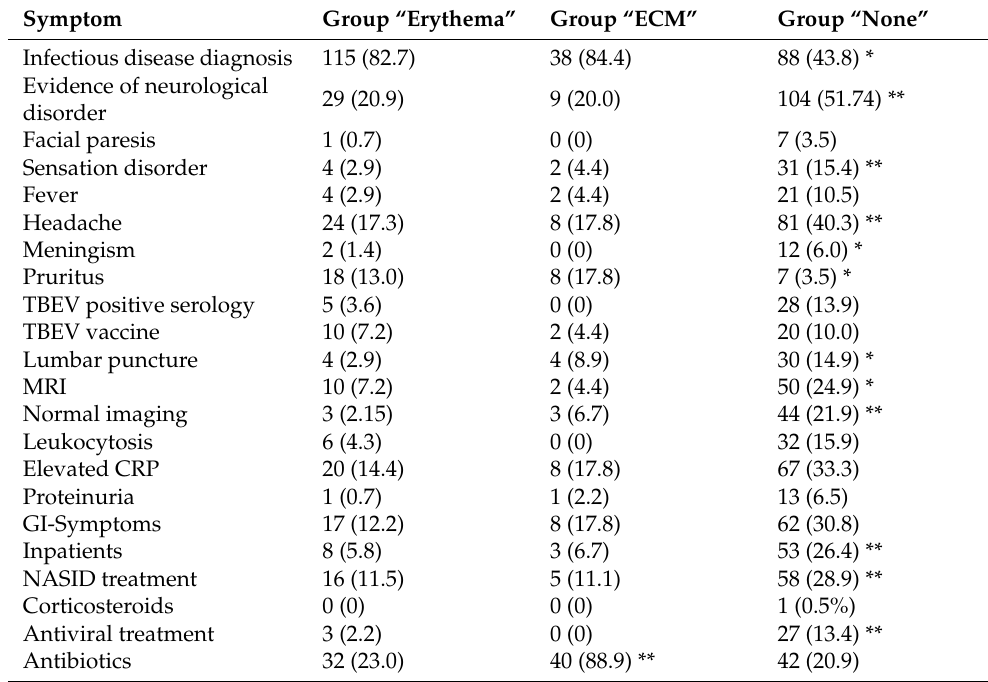
Table 2. Main clinical symptoms by patient group shown as absolute and percentage values relative to the group (in